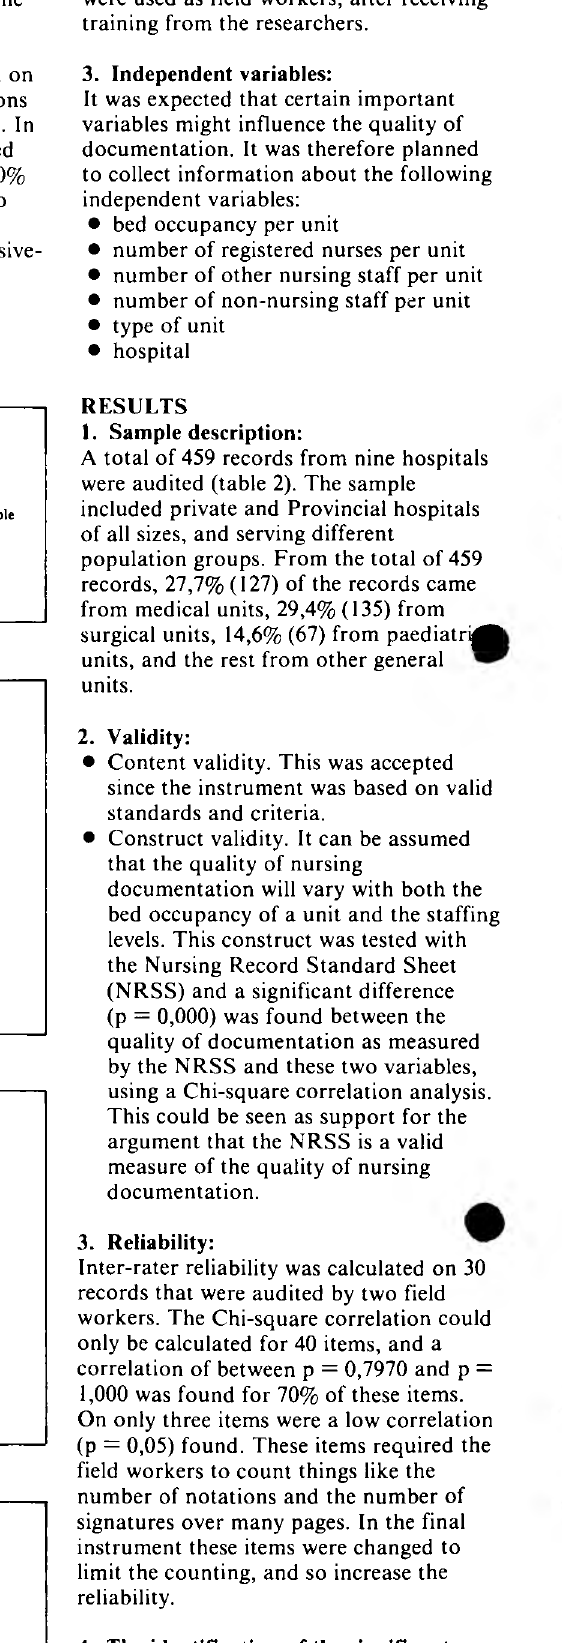
TABLE 4 Expectancy Table: Effect of % Bed Occupancy on Total Quality of